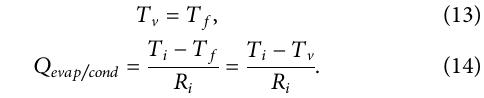
FIGURE 5 | Heat transfer process in the wick.